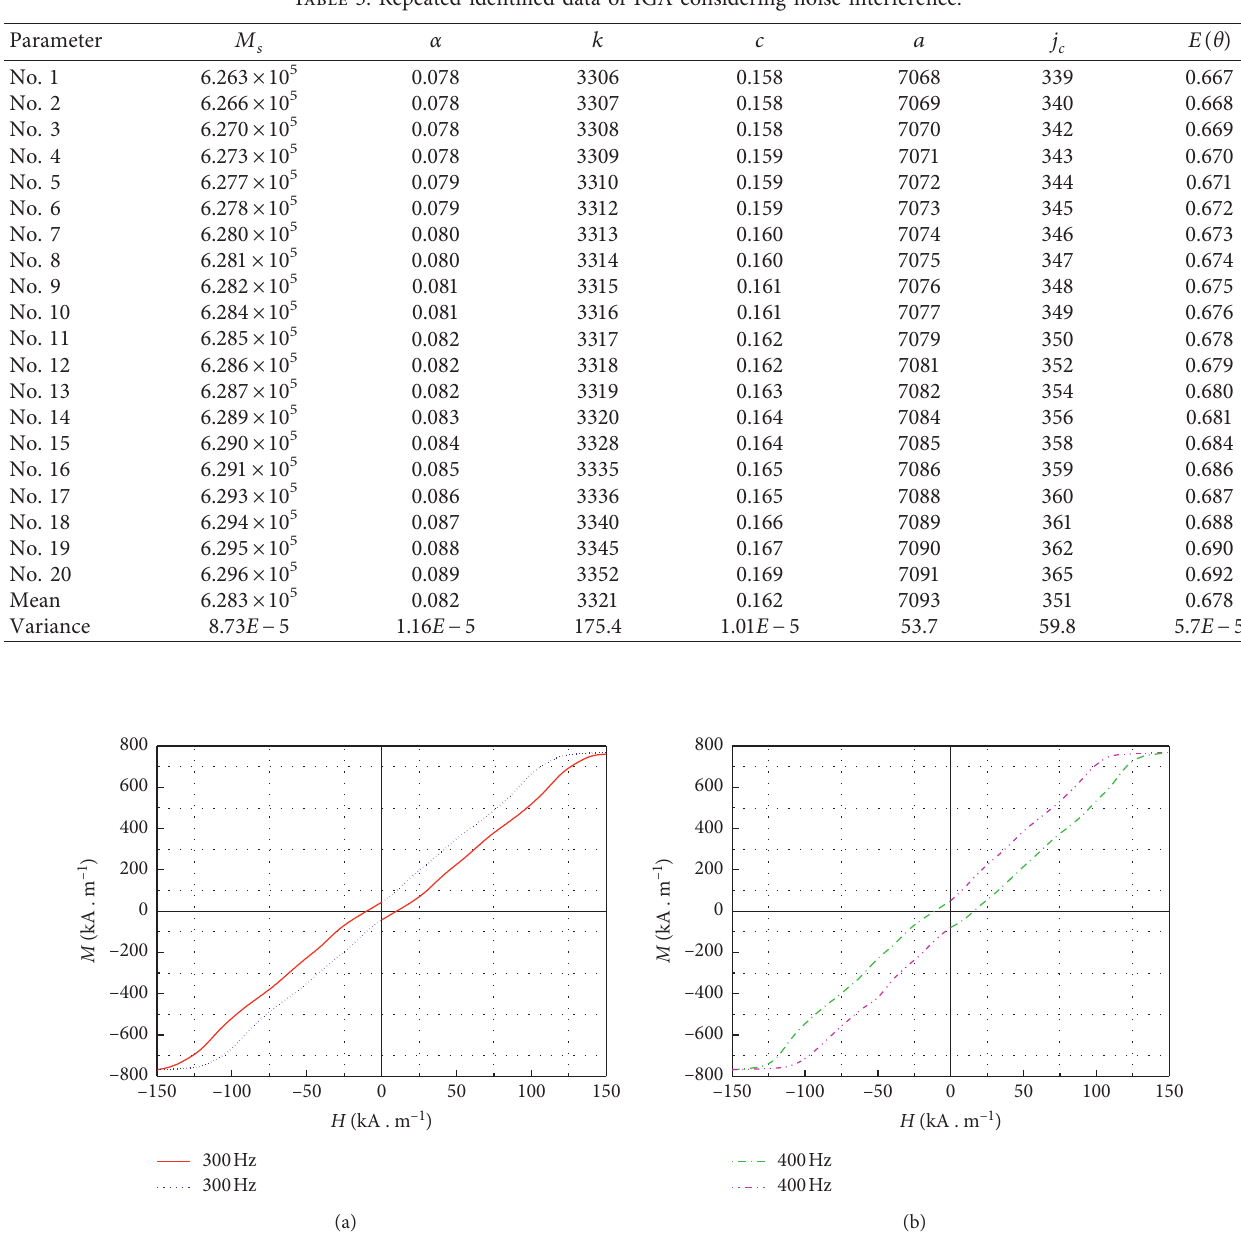
Table 5: Repeated identified data of IGA considering noise interference.